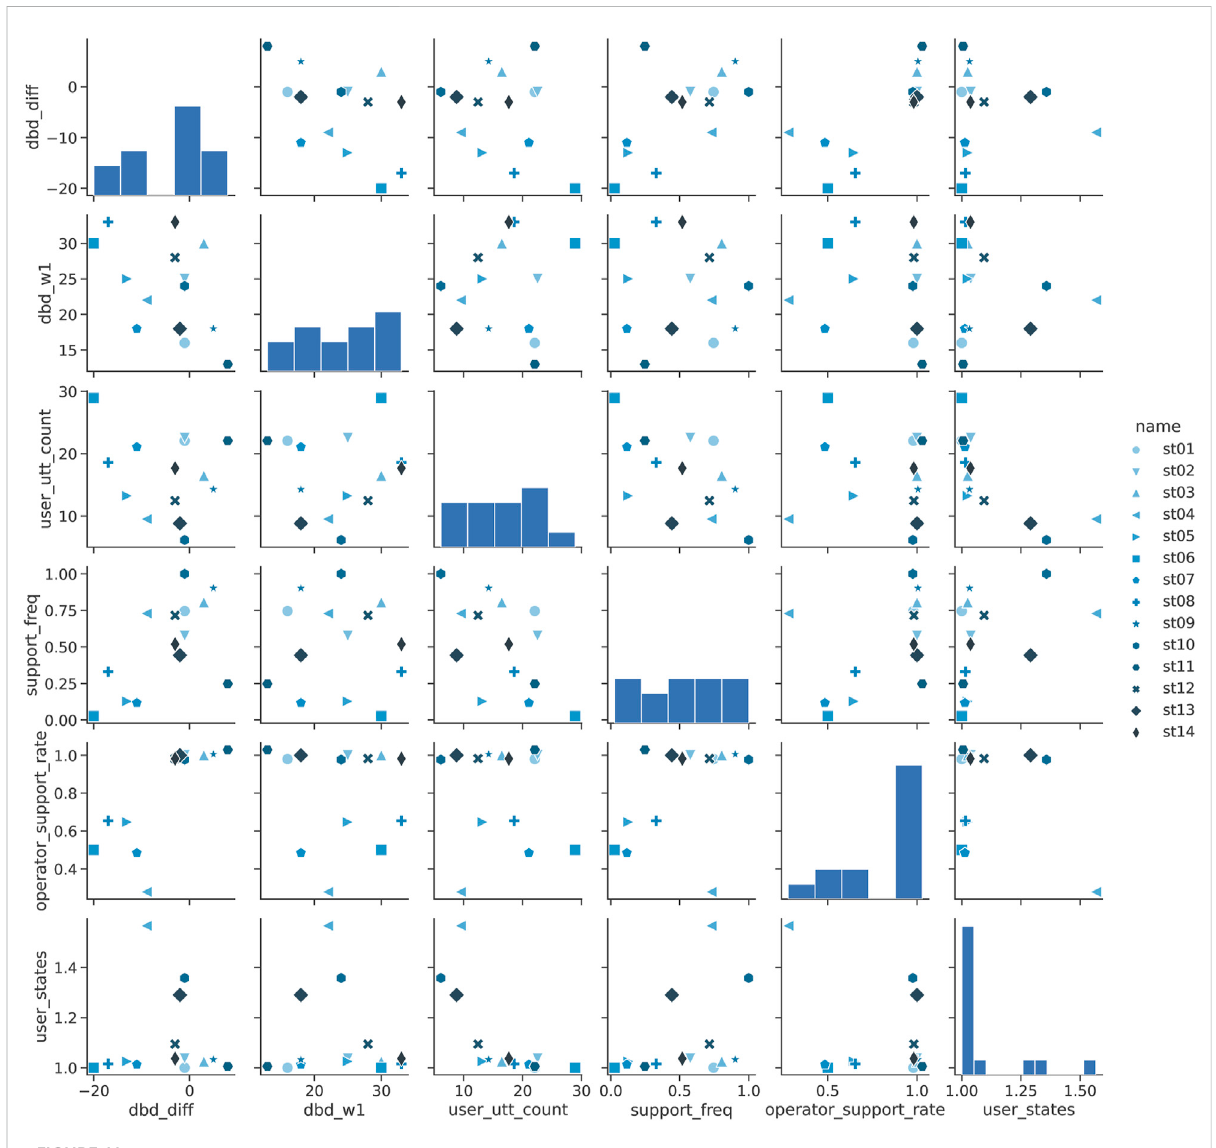
FIGURE 11 Pairplot analysis of DBD in Shiritori